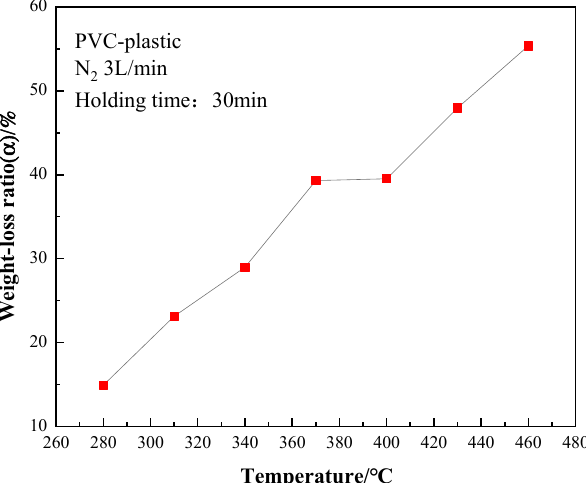
Figure 3. Relationship between heat treatment temperature and weight loss ratio of PVC film.